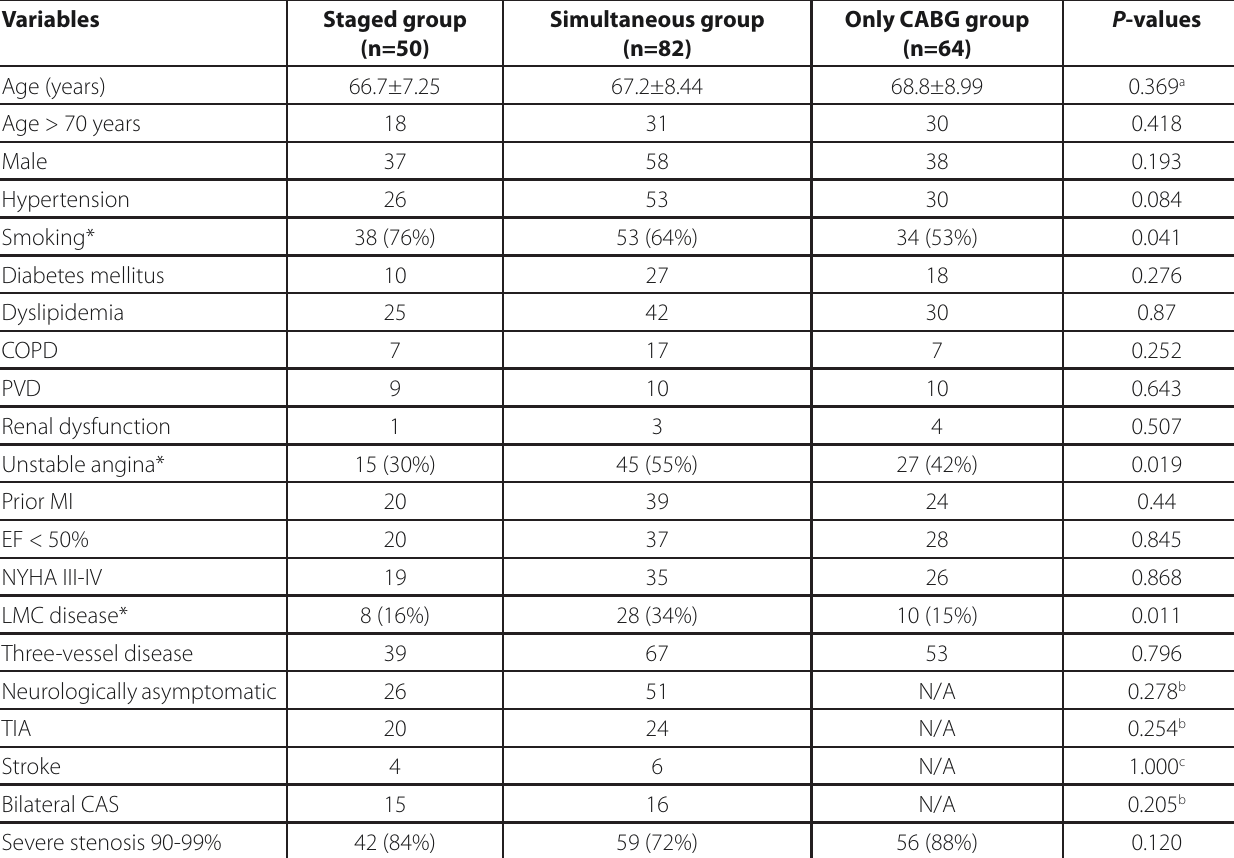
Table 1. Patients’ demographical characteristics and preoperative cardiac and neurological clinical